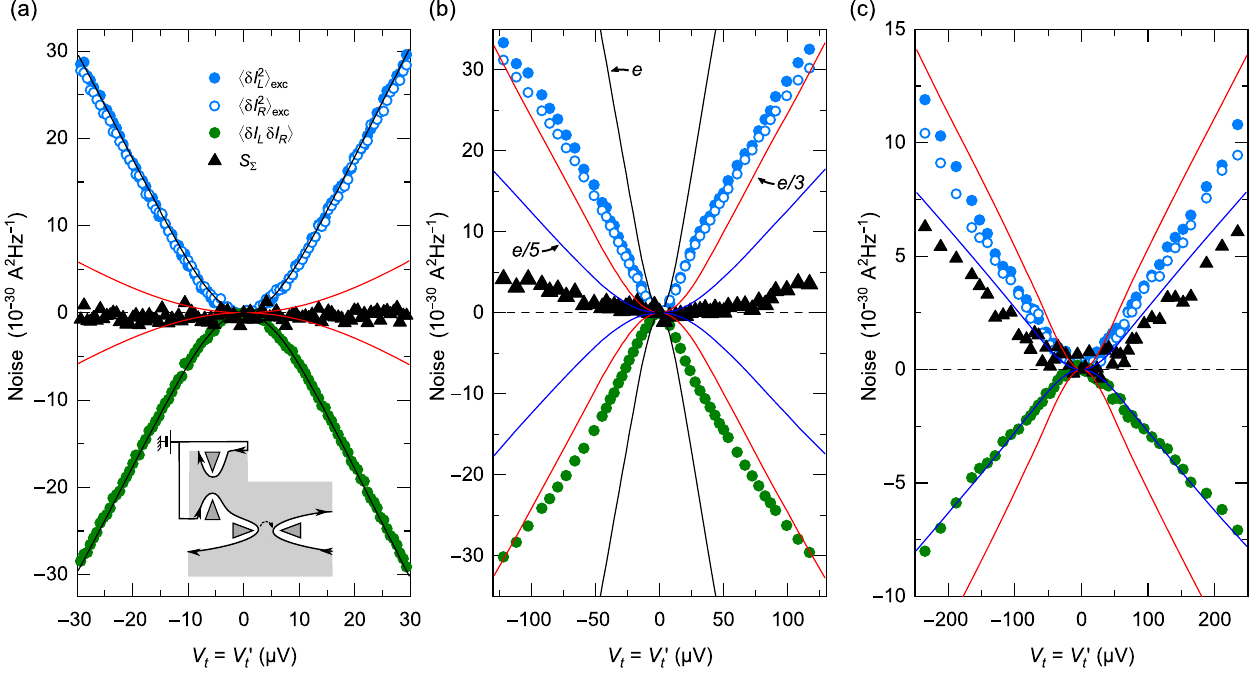
FIG. 14. Auto- and cross-correlation comparison, performed in QPC characterization at filling factor 2 (a), 1 = 3 (b), and 2 = 5 (c) as a c 0 ). Full and open blue disks display the autocorrelation signal from port L and R , V 0 function of the direct applied voltage V ( V t t ¼ b ¼ respectively. Green disks represents the simultaneously measured cross-correlations. S Σ is plotted as black triangles. Continuous lines display ( (cid:3) 1 ×) the predictions of Eq. (3) for a charge e (cid:2) ¼ e (black), e= 3 (red), and e= 5